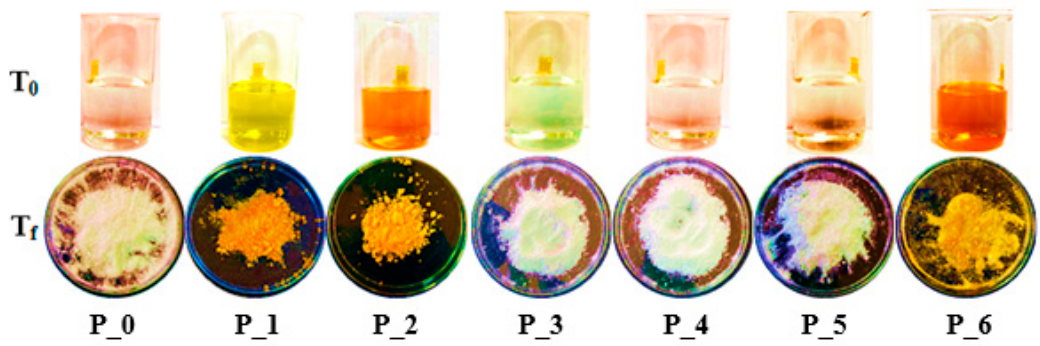
Figure 2. PSAN synthesized formulations ( T 0 —co-crystallization initial time; T f —co-crystallization final time).